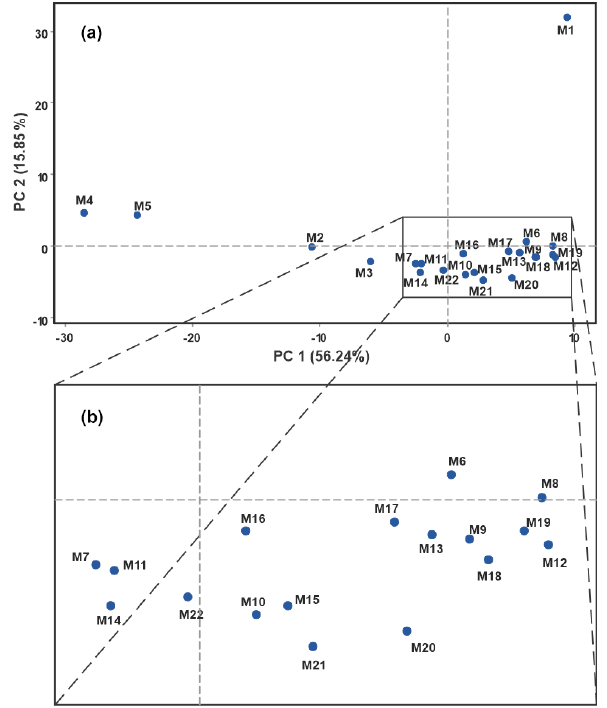
Figure 5. Plot of principal component score of signals collected in drinking water samples by smart electronic